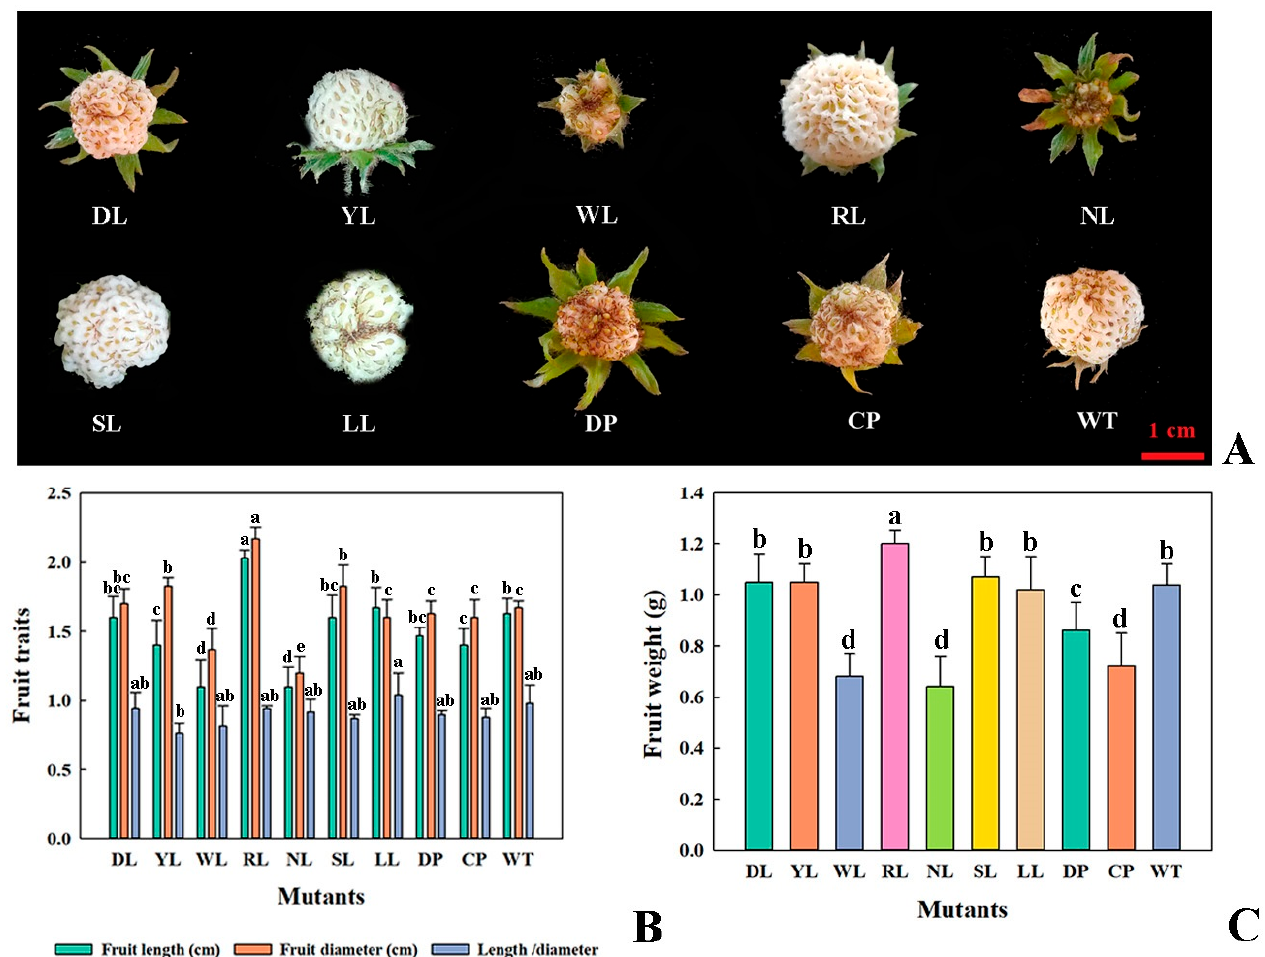
Figure 5. The fruit traits of 9 mutants in F. nilgerrensis . ( A ) Fruits of 9 mutants; ( B ) fruit length, fruit diameter, and length/diameter; ( C ) fruit weight. Abbreviated letters of mutants were described in Figure 2. Bars indicate S.E. of means, and different lowercase letters indicate significant differences between treatments according to LSD test ( p < 0.05). Scale bar = 1 cm.